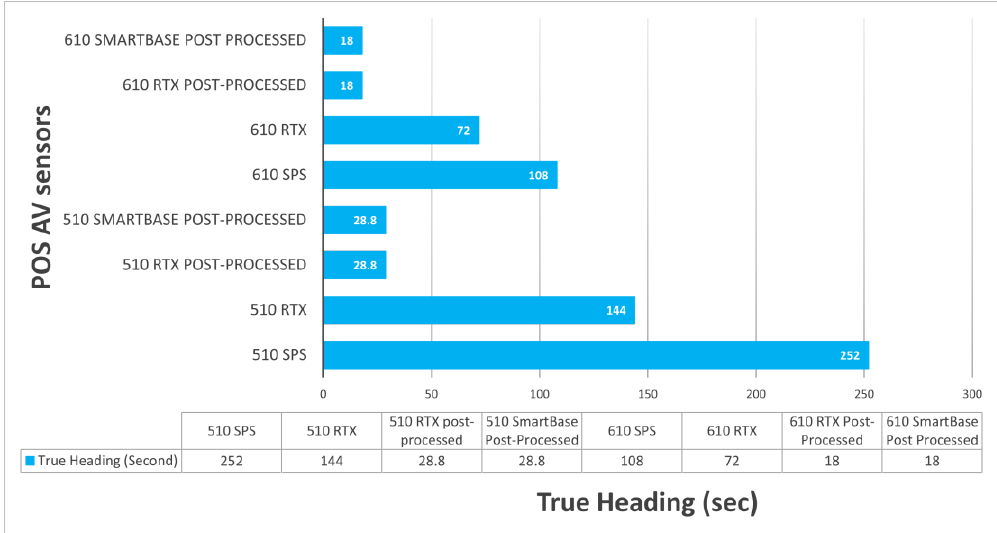
Figure 6. Accuracy of Heading parameters in different POS AV INS